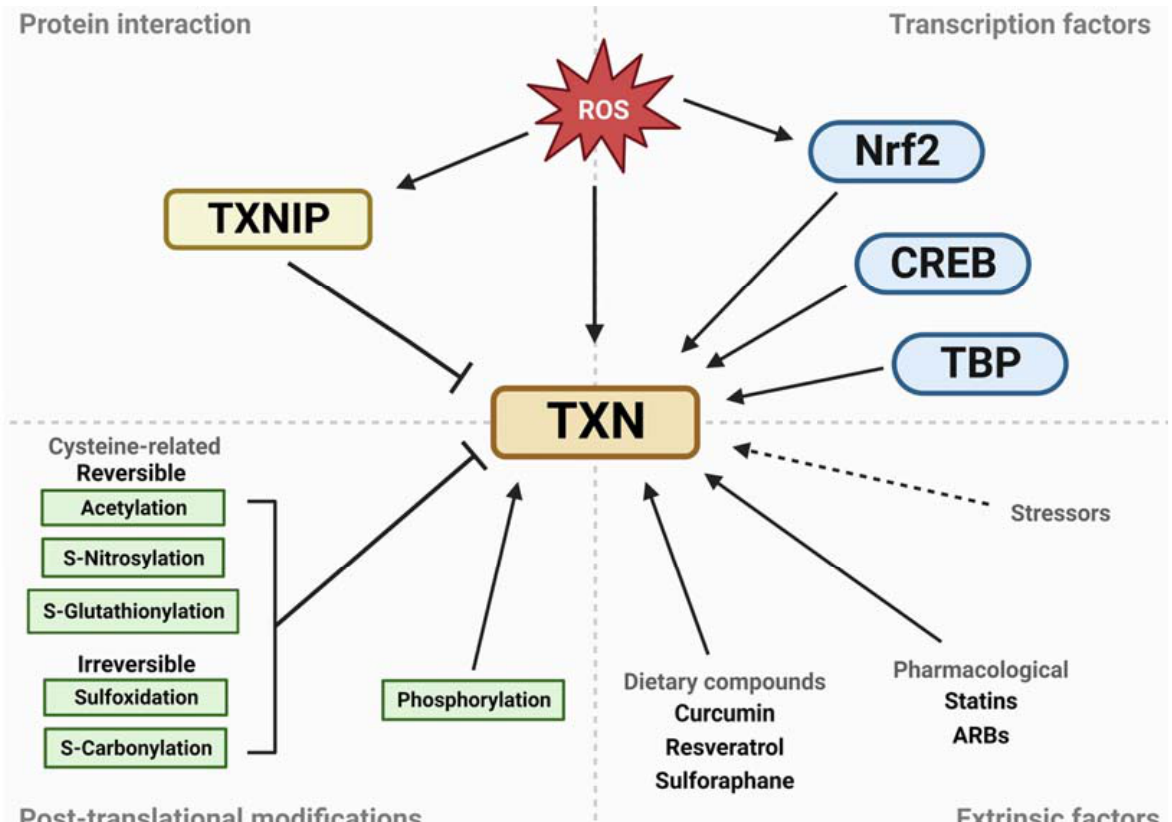
Figure 5. Regulation of the thioredoxin system. The regulation of the thioredoxin system occurs at multiple levels, including gene expression, post-translational modifications, protein–protein inter- actions and extrinsic factors. The thioredoxin system is regulated at the gene expression level by transcription factors, including Nrf2, TBP and CREB, which bind to specific cis-regulatory elements located in the promoter regions of the genes that encode thioredoxin and thioredoxin reductase. Post-translational modifications, such as phosphorylation, acetylation or S-nitrosylation, can also